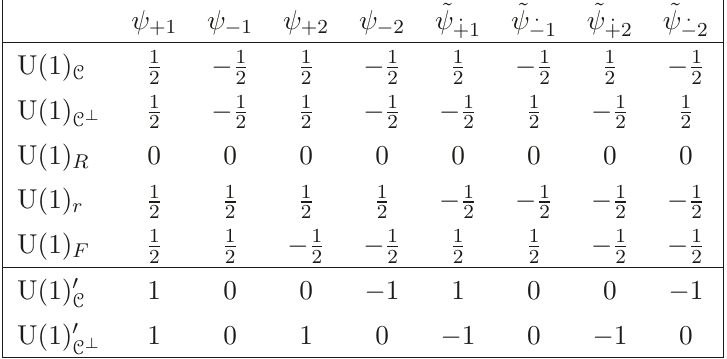
Table 6 . N = 2 hypermultiplet,